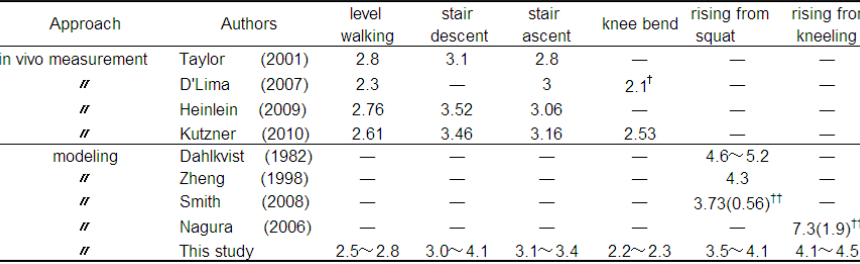
Table 1 Comparison of knee joint forces derived from various approaches.